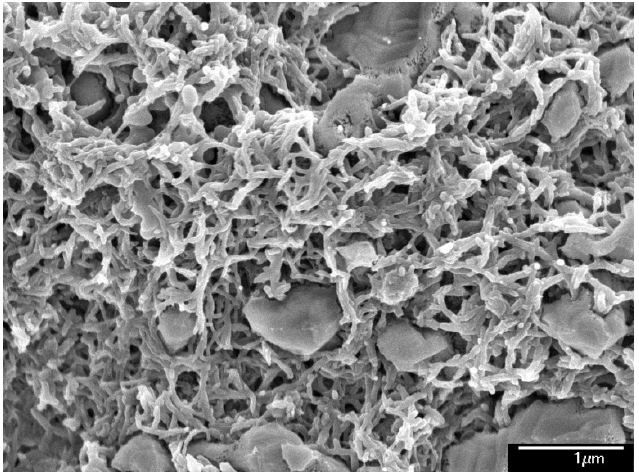
Figure 1. SEM image of the polyaniline/PVA film.